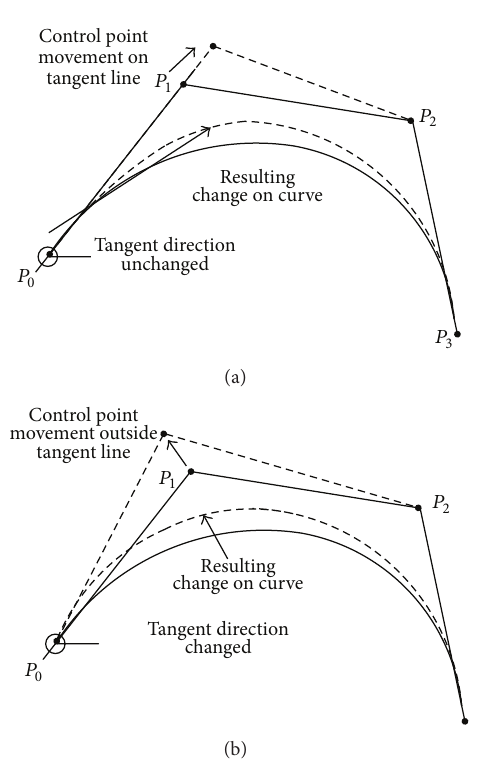
Figure 2: 3D B´ezier curve and its control points.